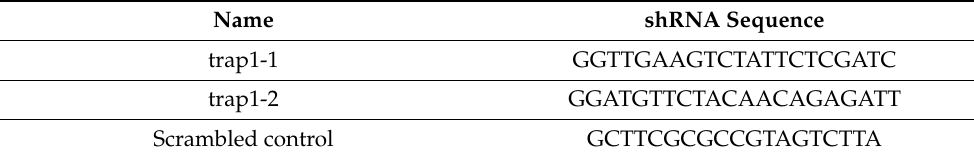
Table 1. shRNA sequences used in this